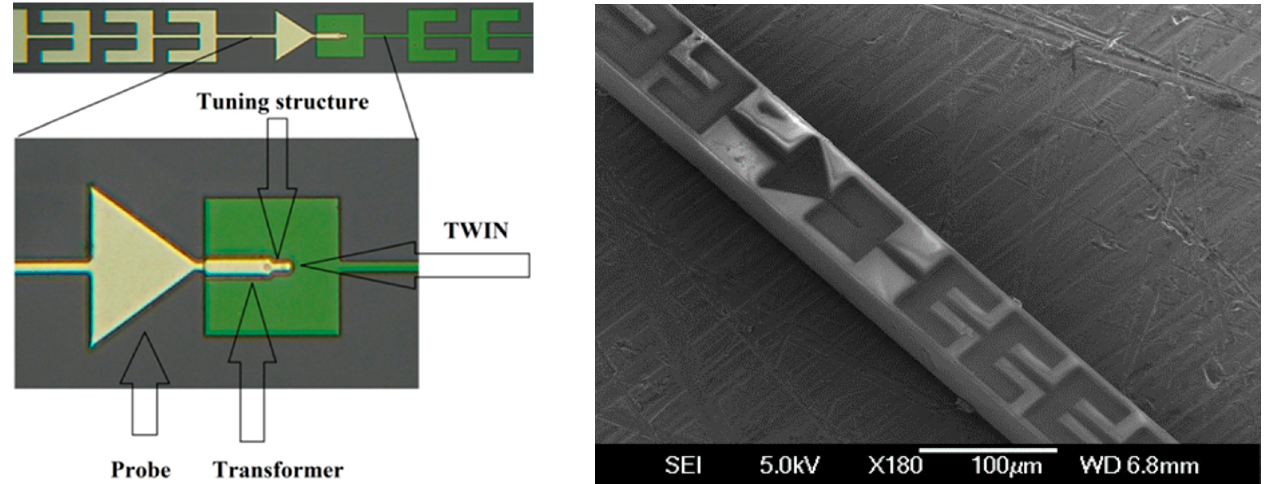
Figure 8. Layout ( left ) and SEM photo ( right ) of the CHAMP+ high band SIS mixer. The central part of the chip (including SIS twin junction, transformer, and probe) is magnified.